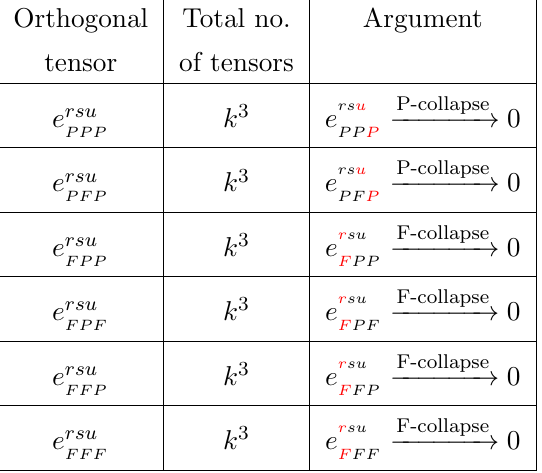
Table 2 . Arguments for the tensors trivially orthogonal to the array of 3 point contour correlators. components in column vector basis satisfy the rules mentioned in B.1. Using these